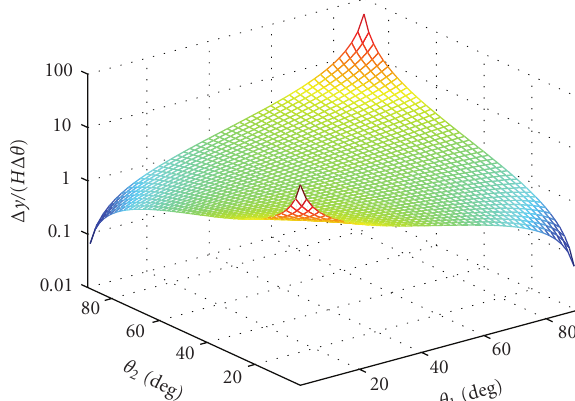
Figure 8: Localization error in the y direction.